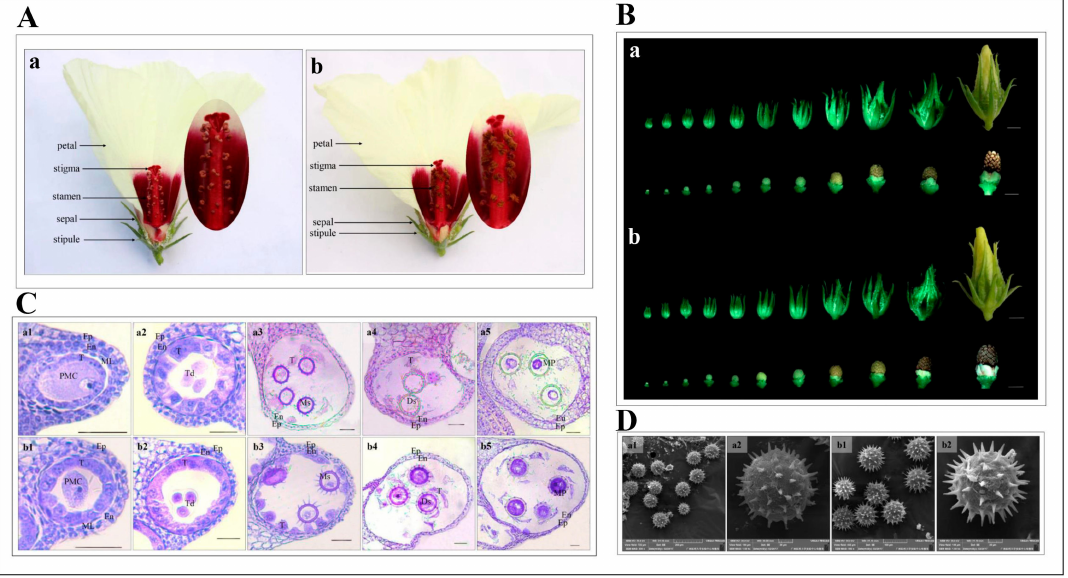
Figure 1. Phenotypic and cytological characterization of kenaf flowers. ( A )